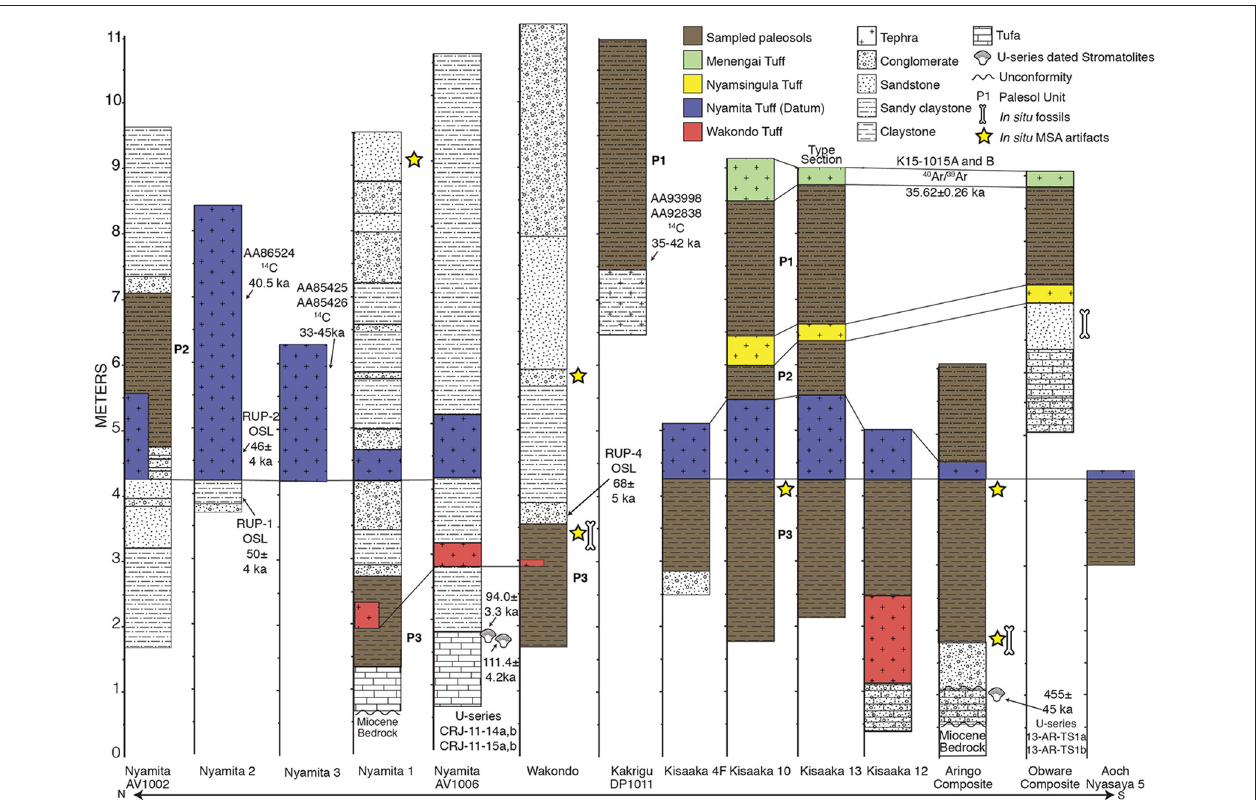
FIGURE 2 | Stratigraphy of paleosols used in this study. The dates (and associated lab samples numbers) identified on this figure are discussed further in Blegen et al. (2015, 2016), Beverly et al. (2015b), and Tryon et al. (2010, 2012). The Nyamita and Wakondo Tuffs at the Nyamita AV1002, Nyamita 1, and Wakondo localities are discontinuous due to their proximity to fluvial channels and are shown in their correlated positions within the paleosols. The localities were sampled to access the most complete paleosol record. Refer to Table 2 for detailed descriptions of each paleosol unit (e.g., P1 to P3).